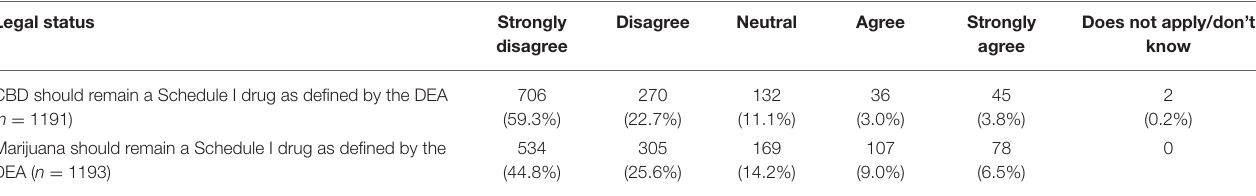
TABLE 9 | Participants’ views regarding legal status of hemp/CBD/marijuana as Schedule 1